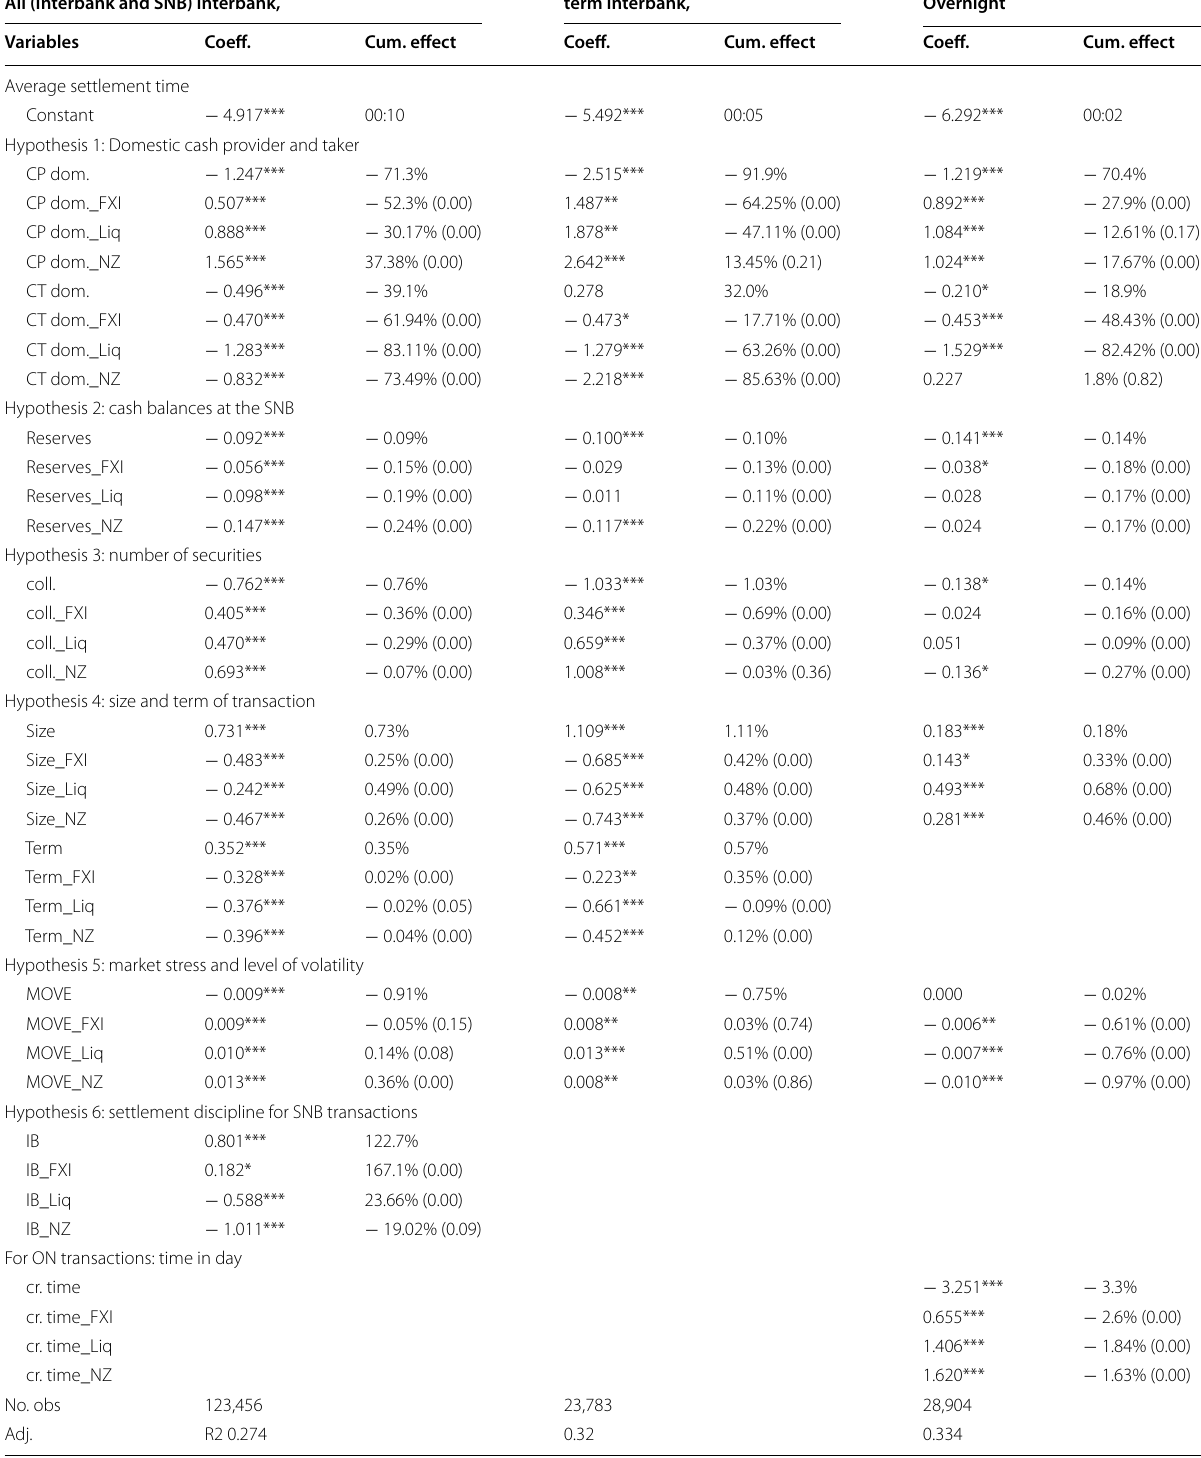
Table 2 Regression